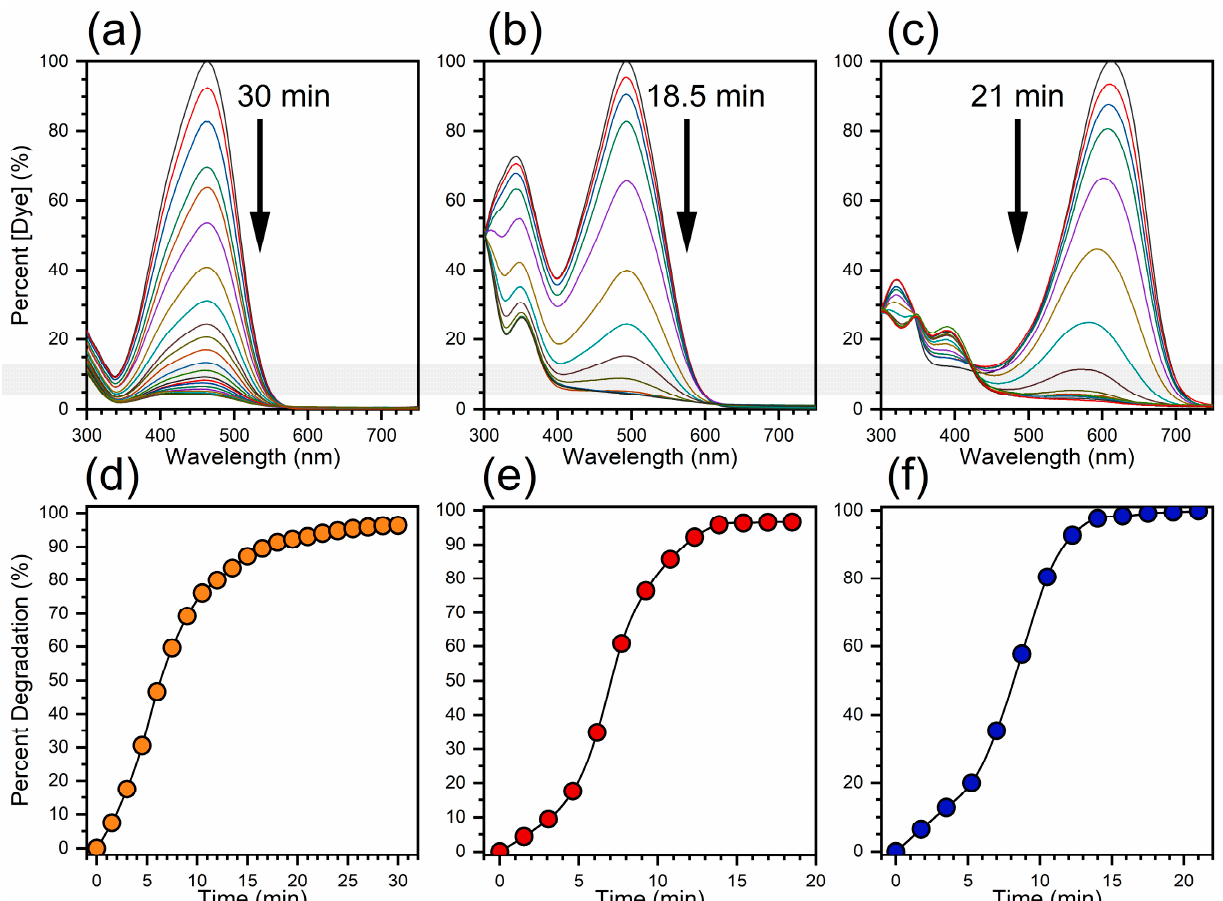
Figure 5. ( a – c ) UV/vis spectra of percentage dye concentration remaining, and ( d – f ) time plots of percentage dye degradation for the catalytic reduction of MO, CR, and CSBB, respectively, by NaBH 4 in the presence of 400 mg Ag NP–cotton.